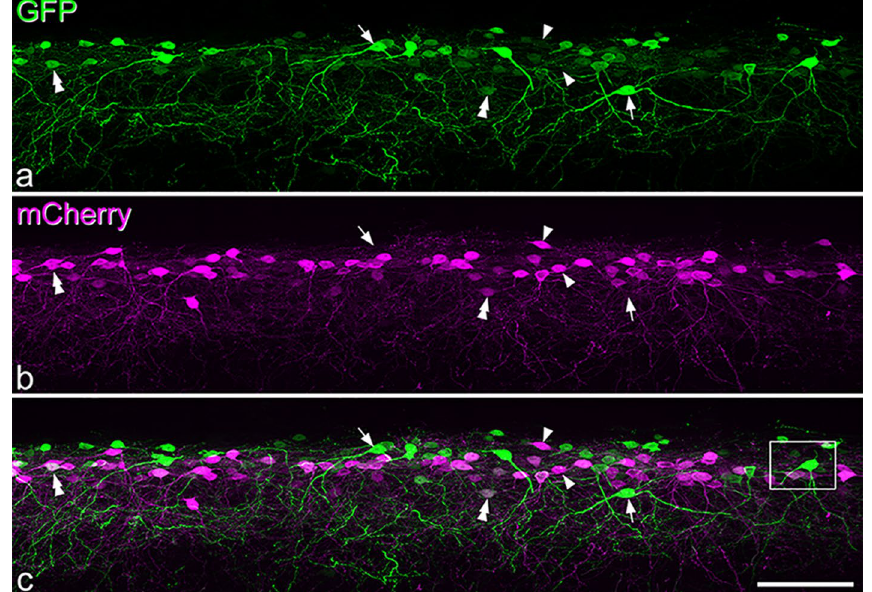
Figure 6. Expression of fluorescent proteins in NPFF Cre ;GRPR Flp mice that had been injected with AAVs coding for Cre-dependent GFP and Flp-dependent mCherry. ( a ) and ( b ) show immunostaining for GFP and mCherry, respectively, in a sagittal section, and ( c ) is a merged image. There are numerous cells with GFP and/or mCherry expression in the superficial dorsal horn. Arrows, arrowheads and double arrowheads show examples of cells that are labelled only with GFP, only with mCherry or with both GFP and mCherry, respectively. Quantitative analysis showed that 39% of GFP-positive cells also contained mCherry, while 36% of mCherry cells were also GFP-positive. The box shows the approximate position of the field illustrated at higher magnification in Fig. 7. Scale bar = 100